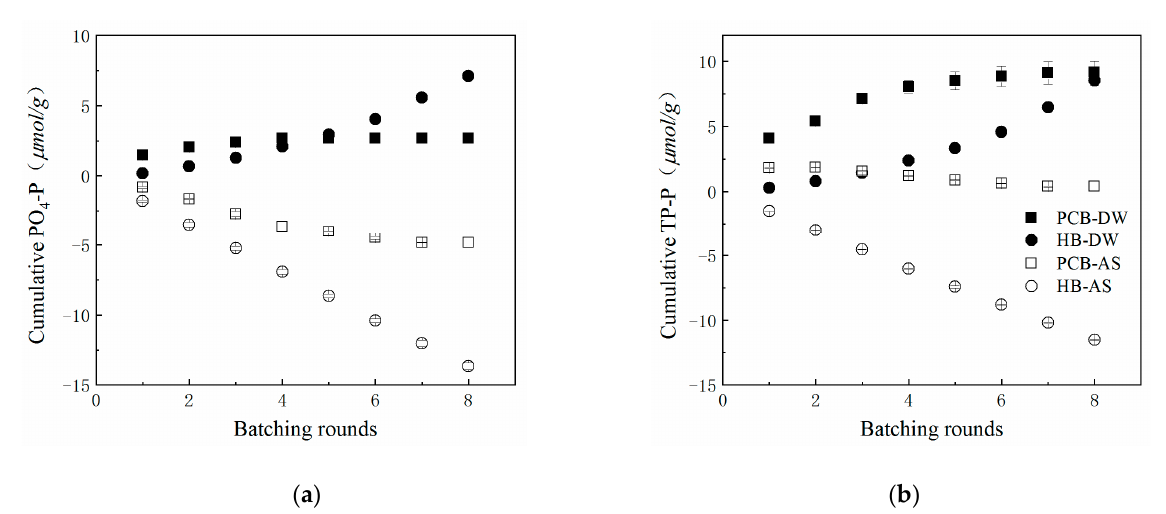
Figure 4. Cumulative phosphorus compounds leached from PCB and HB in DW or AS. ( a ) PO 4 -P; ( b ) TP-P.